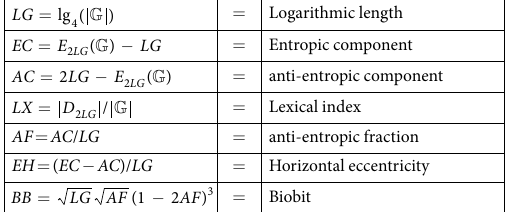
Table 1. Main informational genomic indexes. | D 2 LG | is the number of 2 LG -mers occurring in  , and  is the length of  .